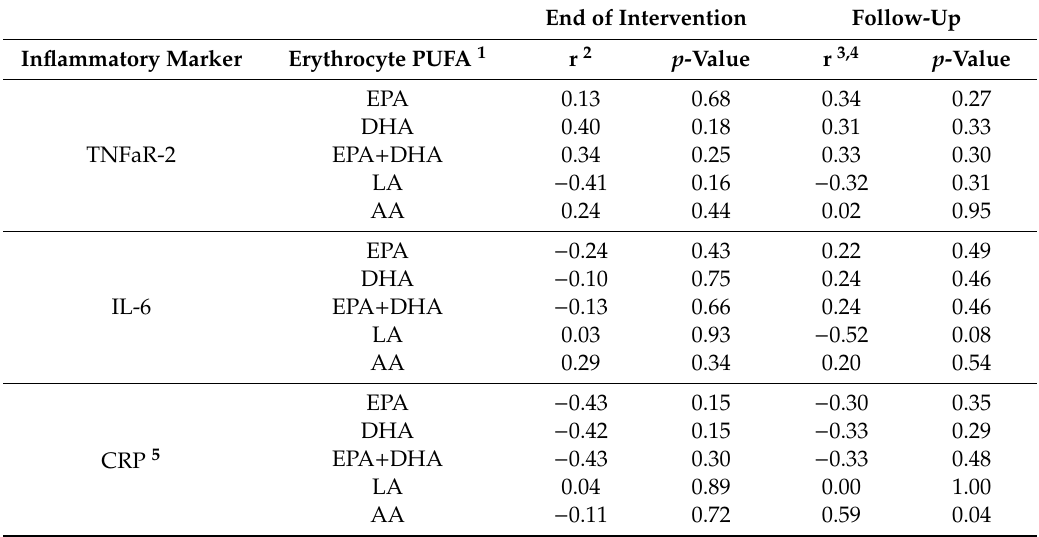
Table 4. Associations between inflammatory markers and erythrocyte PUFA, adjusting for % weight change, among fourteen post-menopausal women completing the LASO-3